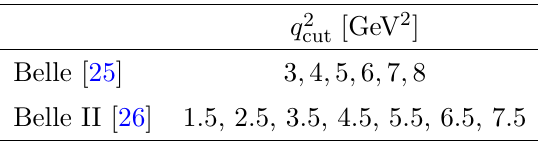
Table 3 . Analyzed measured q 2 moments from Belle and Belle II.